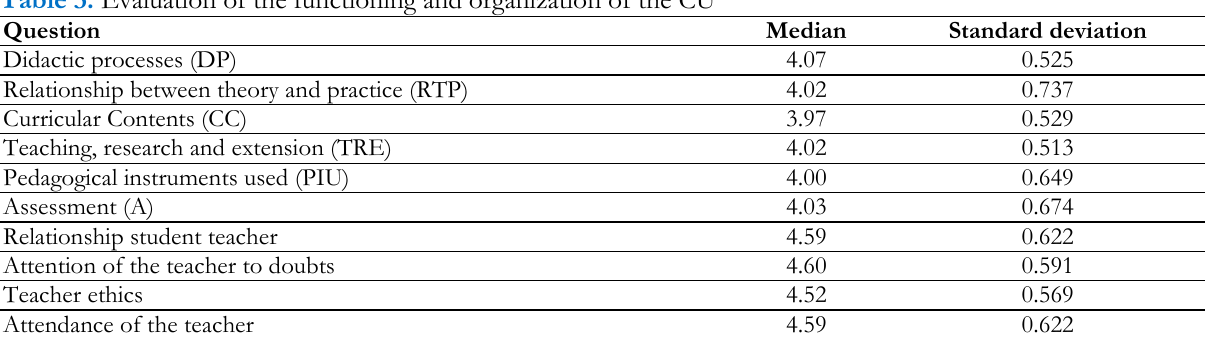
Table 3. Evaluation of the functioning and organization of the CU Question